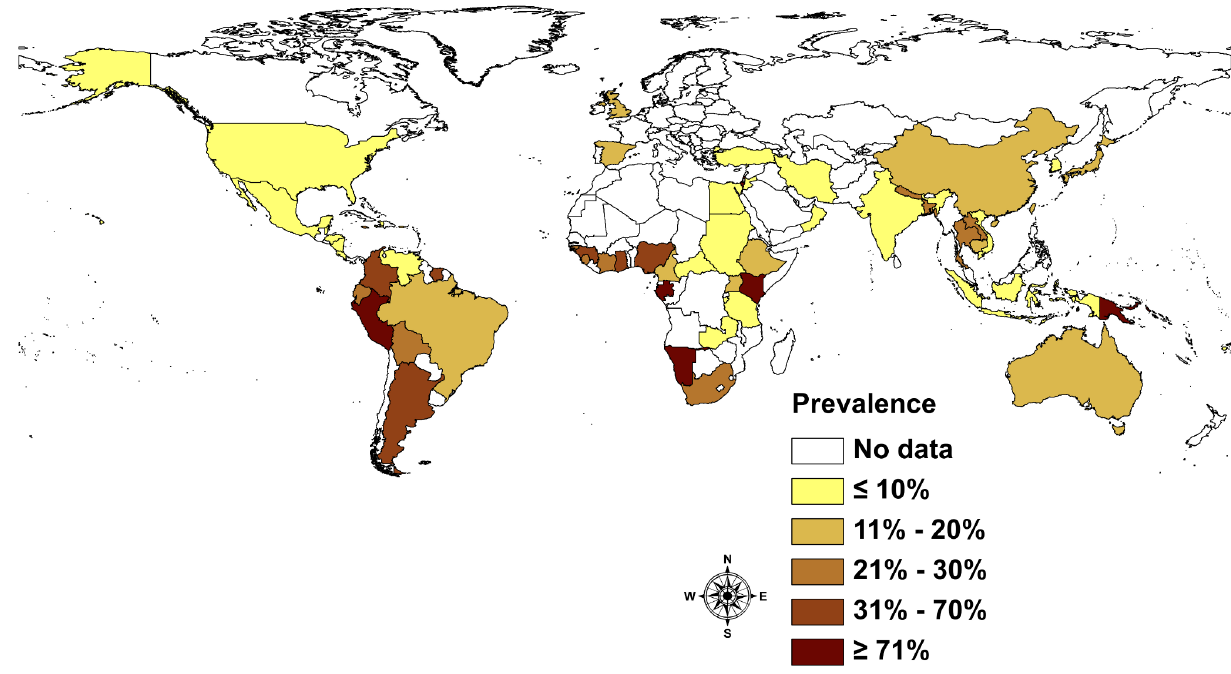
Figure 4. Prevalence of S.stercoralis infection by country based community-based studies.